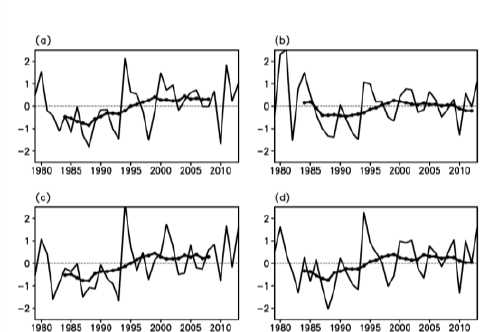
Figure 1. Time series of summer rainfall anomalies (thin lines) and their 11-yr running mean (think lines) over the Indochina Peninsula based on the (a) GPCC, (b) CMAP, (c) GPCP and (d) NOAA Recon